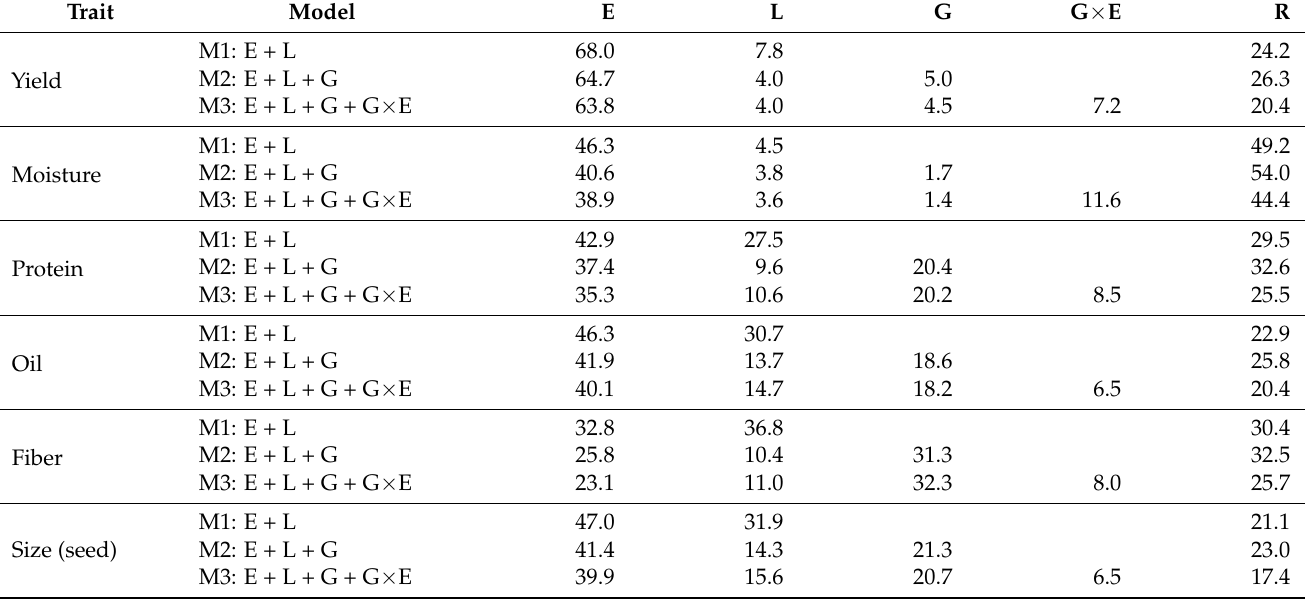
Table 3. Percentage of explained variability by each model term for all traits (6) using phenotypic and genomic data from the SoyNAM experiment for 324 genotypes observed in 6 environments. Three models were considered, and these were constructed with the following components: E, main effect of environments; L, main effect of genotypes; G main effect of markers; and G × E for the interaction between genotypes and environments using marker data.